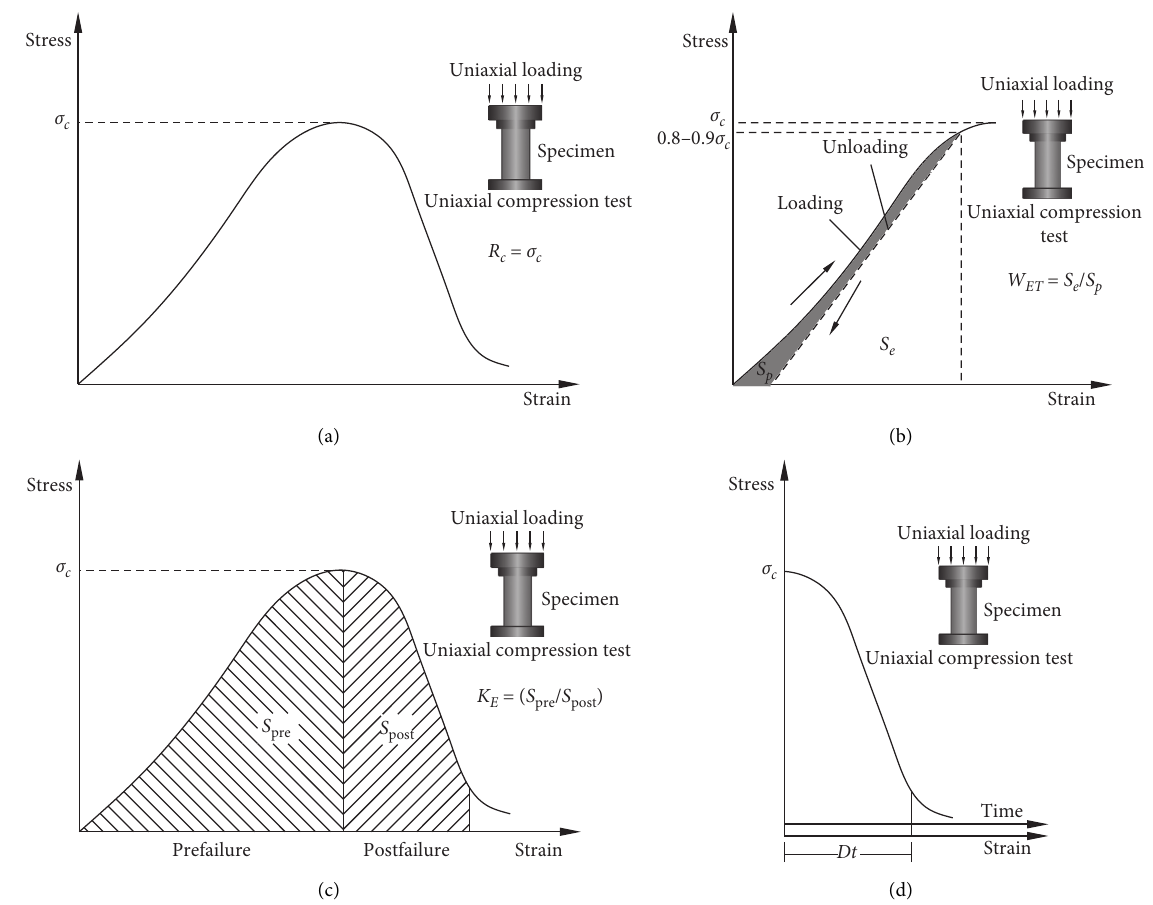
Figure 1: Four indices obtained from the uniaxial compressive test and employed to classify the bursting proneness of coal: (a) uniaxial compressive strength ( R c ); (b) elastic strain energy index ( W ET ); (c) bursting energy index ( K E ); (d) duration of dynamic fracture ( D t ).